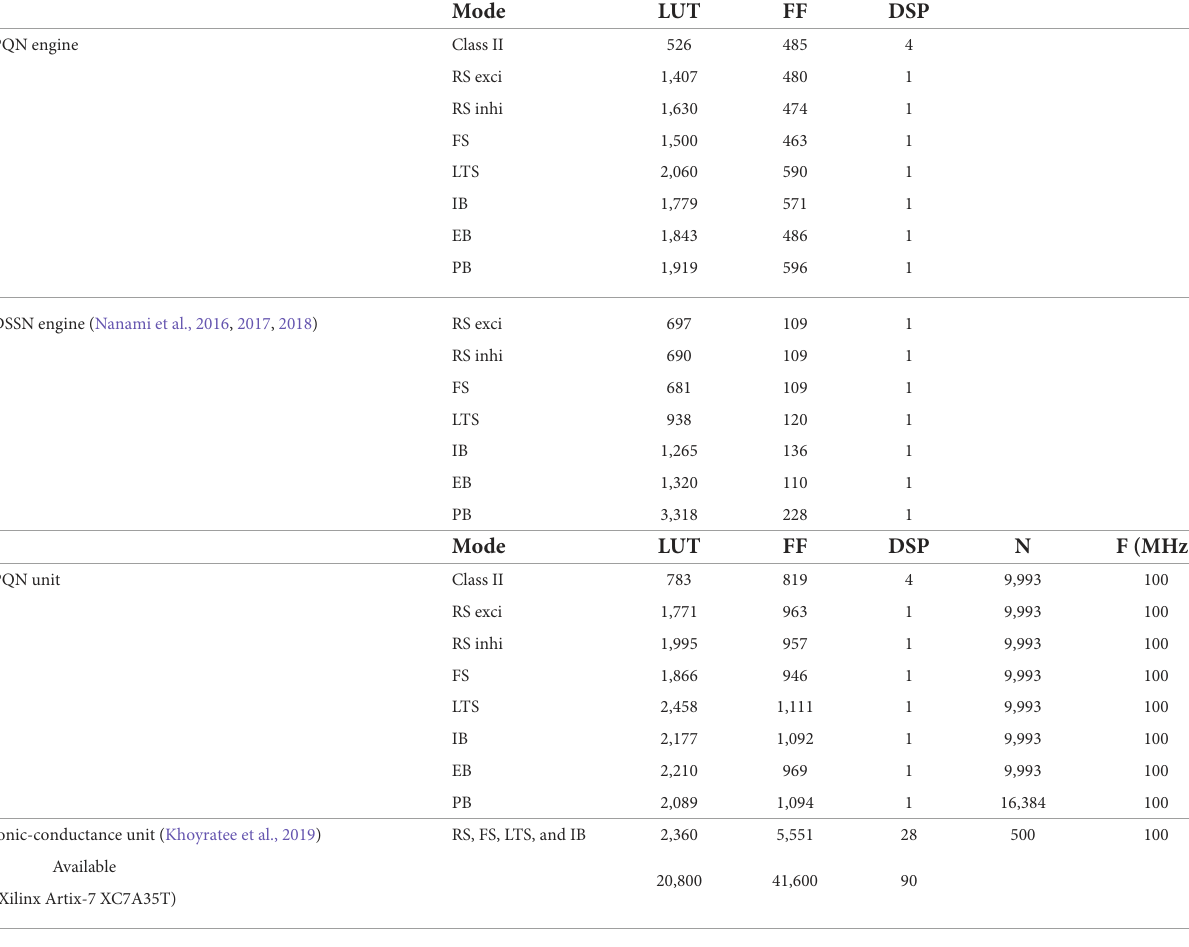
TABLE 1 FPGA implementation results of the PQN, DSSN, and ionic-conductance models.